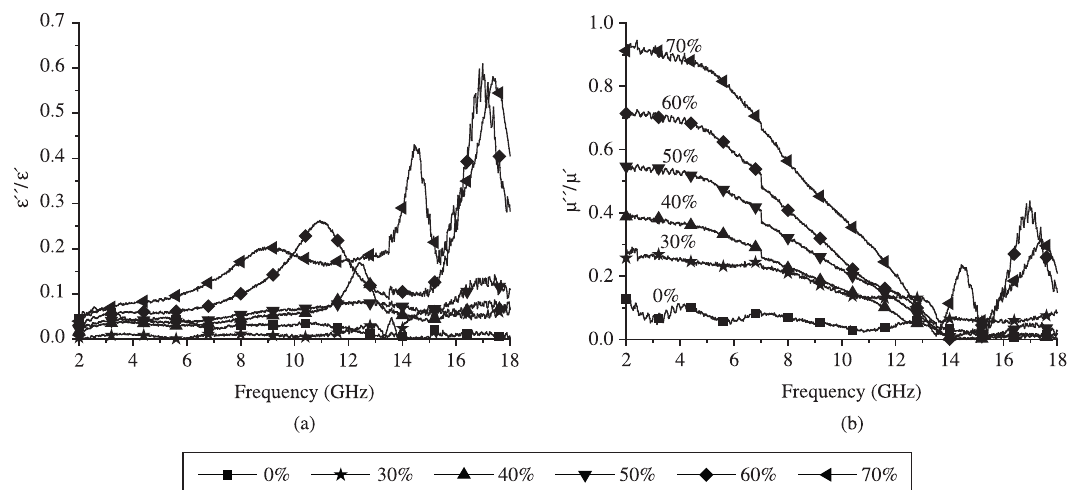
Figure 6. (a) Dielectric and (b) magnetic loss tangents curves for RAM based on MnZn ferrite (0, 30, 40, 50, 60 and 70% (w/w)) in function of the